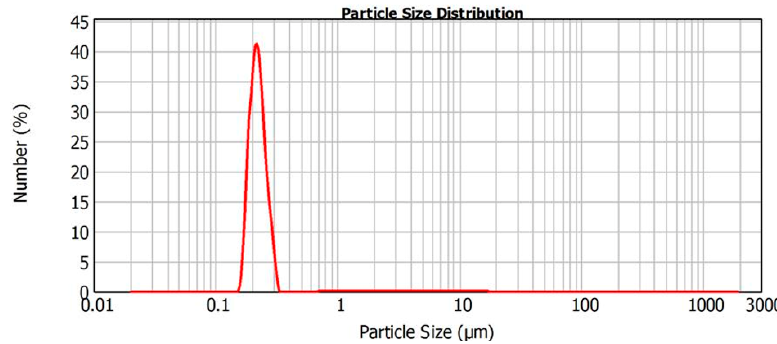
Figure 2. Particle size distribution of synthesized LiNbO 3 powder.